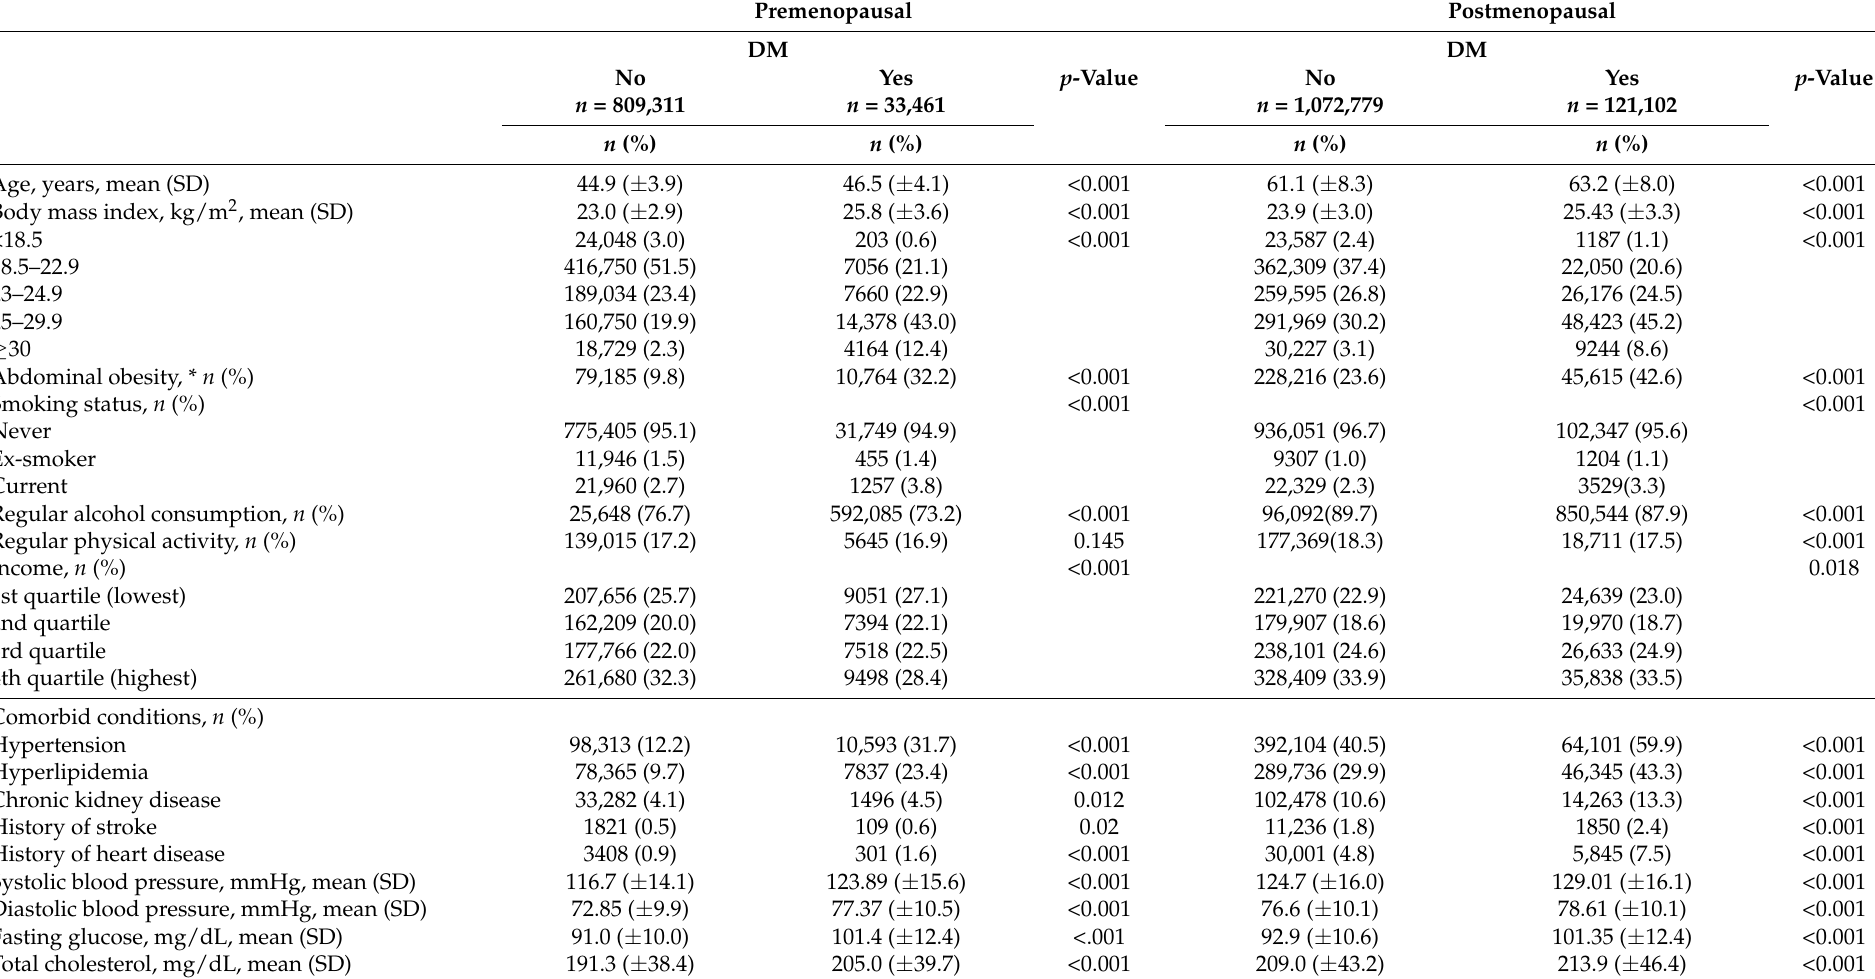
Table 1. Baseline Characteristics and comorbidity of the Study Population according to Menopausal